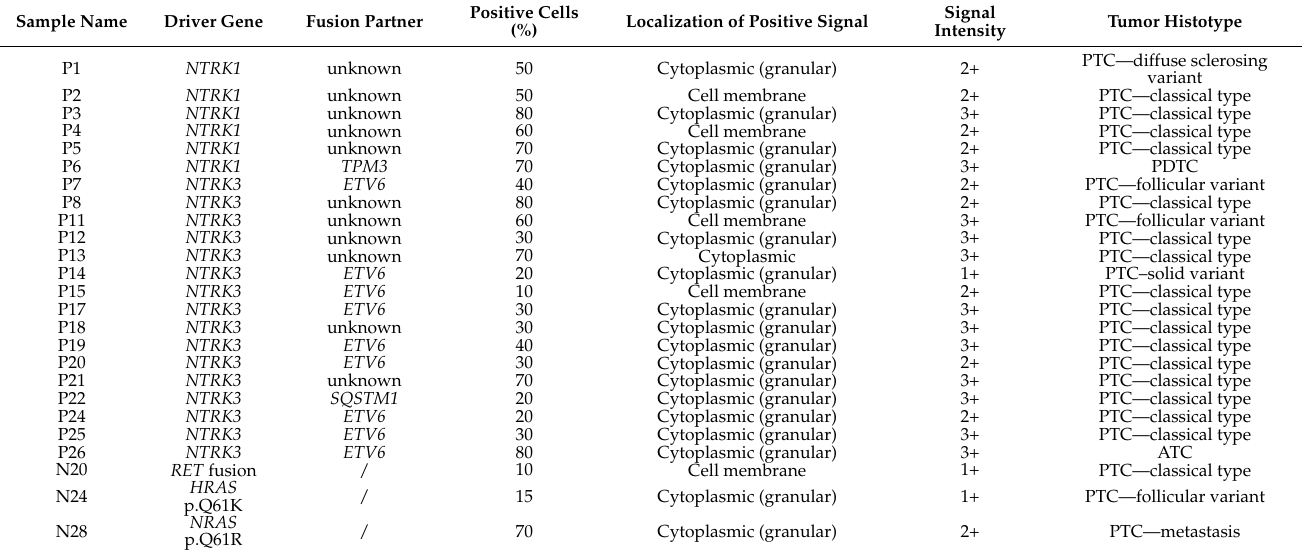
Table 1. Characteristics of 25 thyroid tumors showing positive immunohistochemical Trk stain. The NTRK gene, the fusion partner gene (if known), the percentage of positive tumor cells, signal localization and intensity, and tumor histotype are reported. For samples positive for Trk expression but negative for NTRK rearrangements (N20, N24, N28), the driver alteration is indicated.